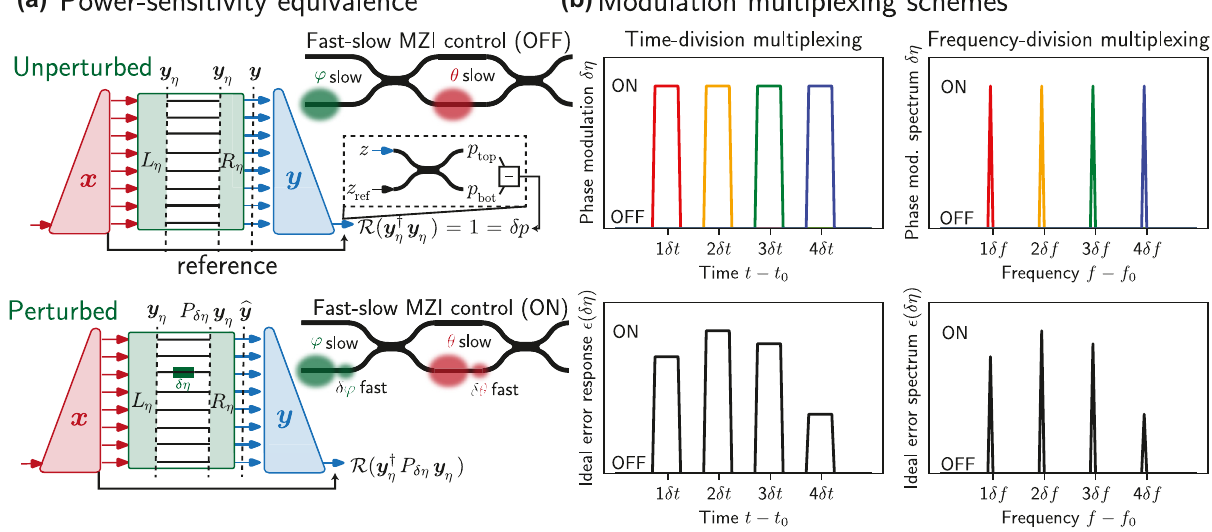
Figure 1: Power monitoring scheme: (a) The architecture of phase modulation sensitivity analysis is constructed from three subunits: the generator (red) to generate the signal, mesh (green) to transform the signal, and analyzer to compute signal transform monitor function via vector product (blue). Regardless of the actual input/output behavior (assuming no loss), modulation compares the response where all phase shifts are unperturbed and correctly set (OFF) to the response where to a given phase shift is perturbed (ON). In the ON state for a given phase shifter, subtracting the bottom waveguide from top waveguide gives the error modulation signal 𝜀 ( 𝛿𝜂 ( t )) from which the powers may be extracted as in Eq. (3). (b) Assuming some fixed U , x , different multiplexing formats (top) result in different 𝜀 ( 𝛿𝜂 ( t )) (bottom, black) but ultimately yield the same response after demultiplexing. Whether the multiplexing is done in time or in frequency, either technique can isolate small-signal responses in the monitor function for the various different phase shifts (indicated by color) given necessary constraints (e.g., all frequencies must lie with an “octave,” or between f spurious readings during